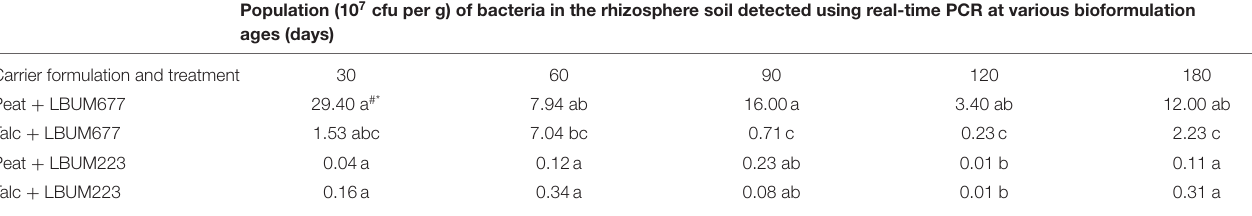
TABLE 2 | Rhizosphere competence of LBUM677 and LBUM223 bioformulations as determined by measuring the populations of each bacterium in rhizosphere soil using real-time PCR when the bioformulations reached different